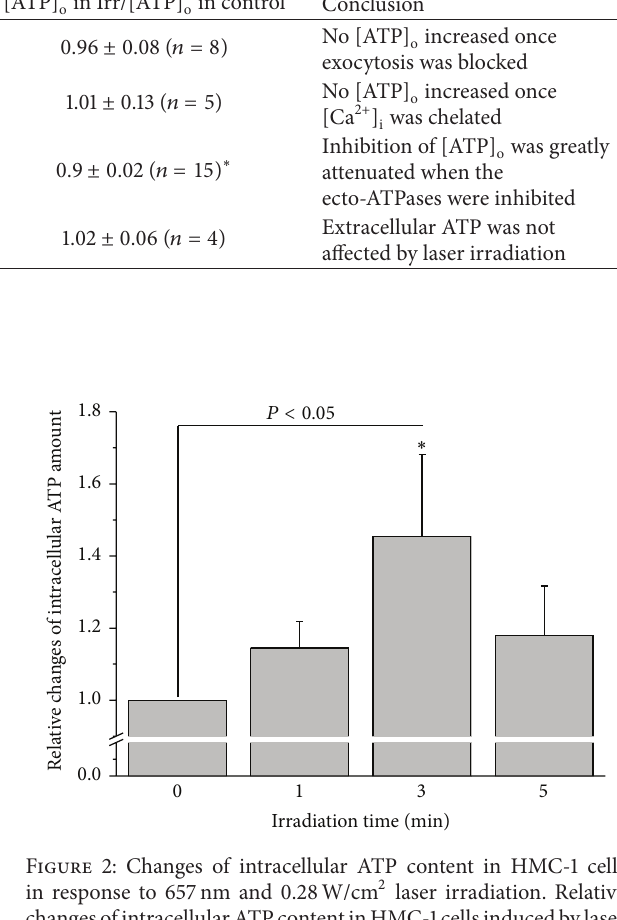
Differences between sample averages were compared by one- way ANOVA, and 𝑃 < 0.05 was considered to represent statistically significant difference.